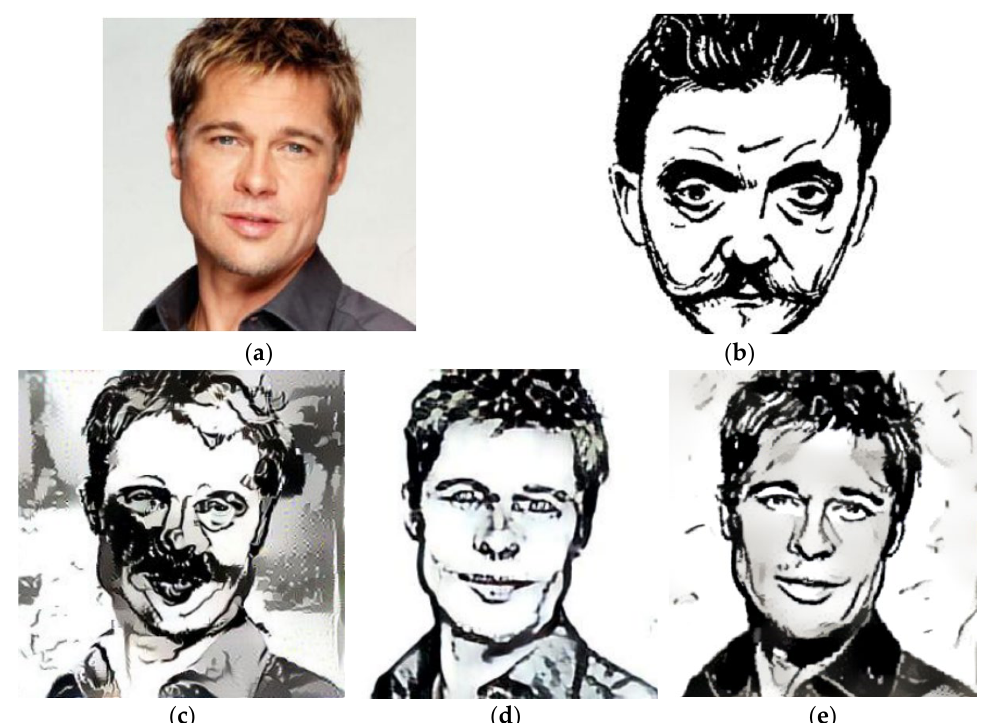
Figure 21. The comparison of the methods of Gatys et al., X. Li et al., and the proposed method. ( a ) Content image. ( b ) Target image. ( c ) The results of Gatys et al.’s method. ( d ) The results of X. Li et al.’s method. ( e ) Our result.